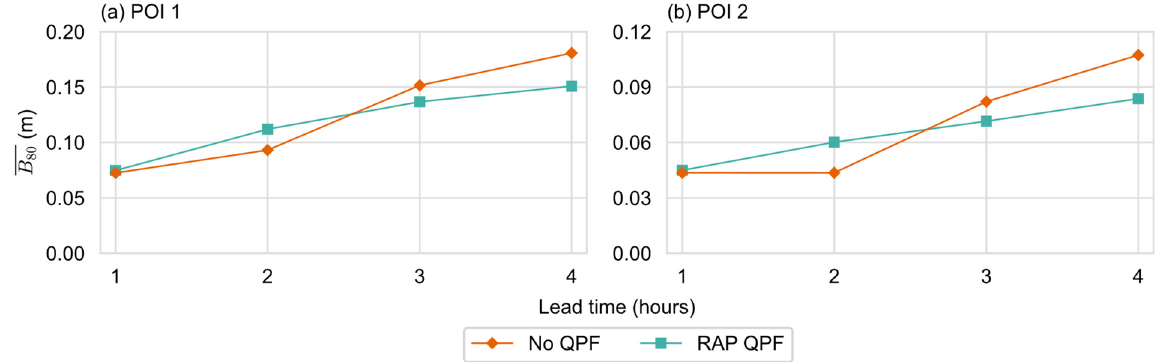
Figure 9. Mean 𝐵 (cid:2876)(cid:2868) for the three test events at ( a ) POI 1 and ( b ) POI